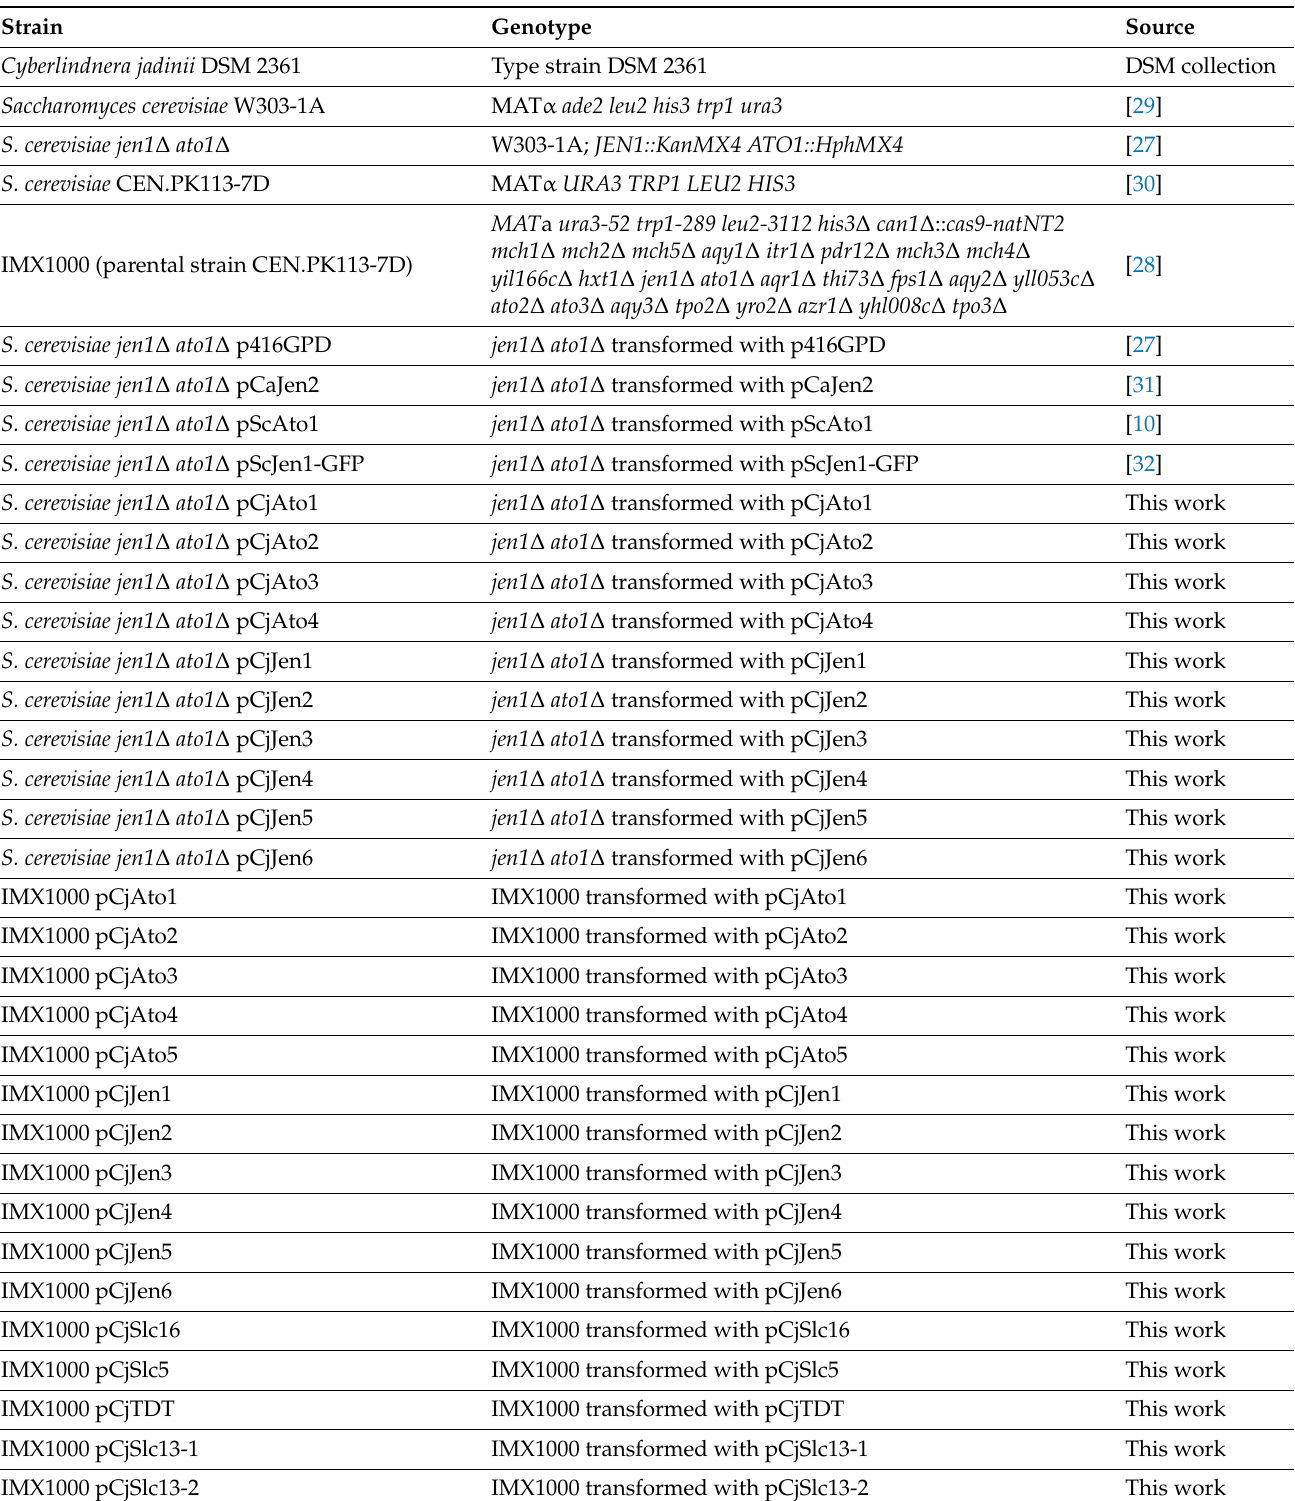
Table 1. Yeast strains used in this